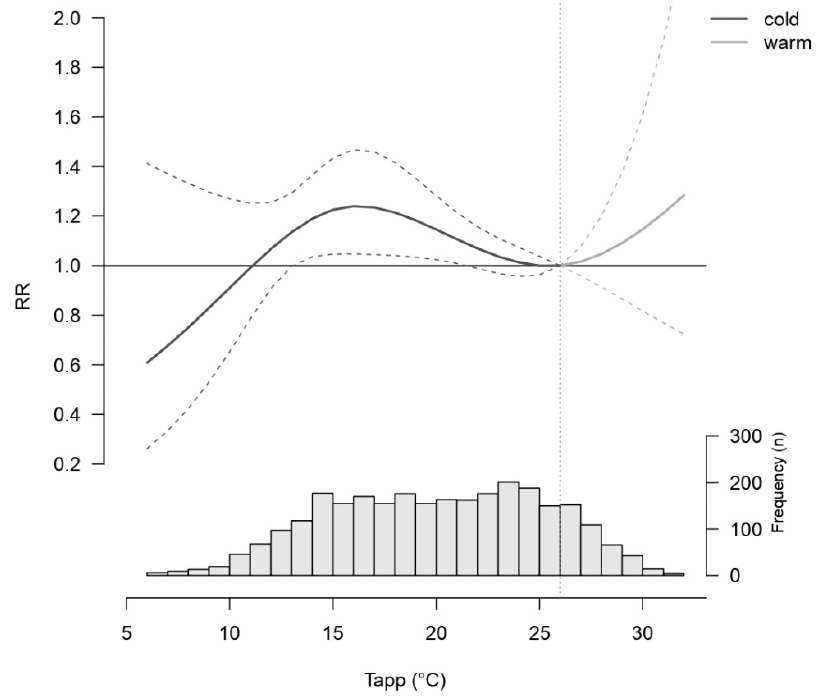
Figure 4. The relative risk (RR) of CVD hospital admissions from apparent temperature (T app ) accumulated over 21 days of lag. The grey vertical dotted line marks the optimal T app of 26 °C, against which the risk for other T app was compared. The graph represents the RR for cold (dark) and warm (grey) T app . The dotted lines represent the 95% confidence interval. The histogram shows the frequency of each T app during the study period.